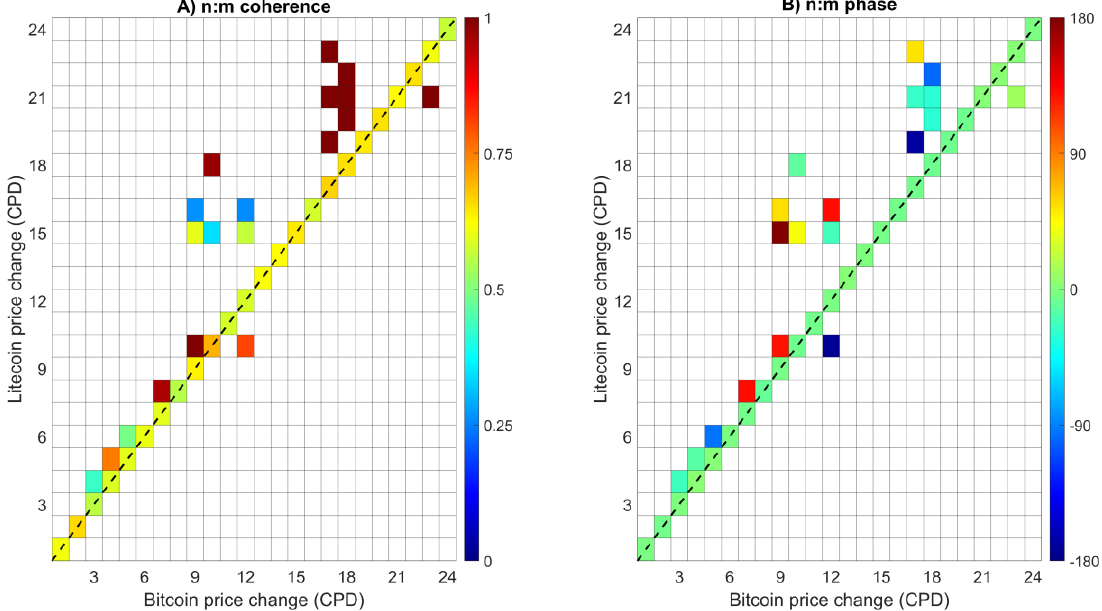
Fig. 1A. n:m coherence between intra-day price changes of Bitcoin vs. Litecoin. Both iso- frequency (1:1) and cross-frequency coupling (m:n, where m ≠ n) were detected. Cross frequency coupling includes both integer and non-integer harmonic (m > n) and sub-harmonic (m < n) coupling. Thus, harmonic and sub-harmonic coupling includes all the coupling values above and below the iso-frequency coupling respectively (indicated by the black dashed diagonal line). Coherence values below the significance level are rendered 0 and omitted for clarity. 1B. n:m phase between intra-day price changes of Bitcoin vs. Ethereum. Phase values are in degrees and range from -180 to +180. [CPD = cycles per